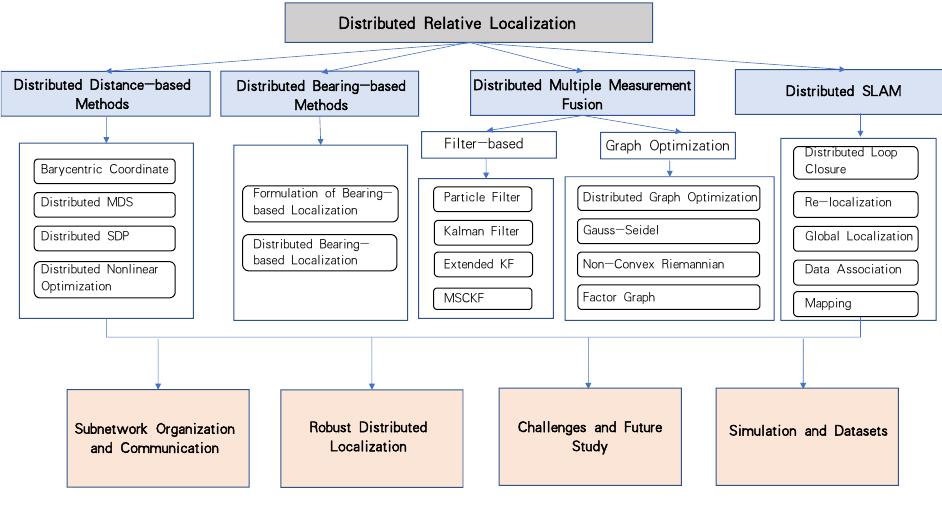
Figure 1. The main content of this